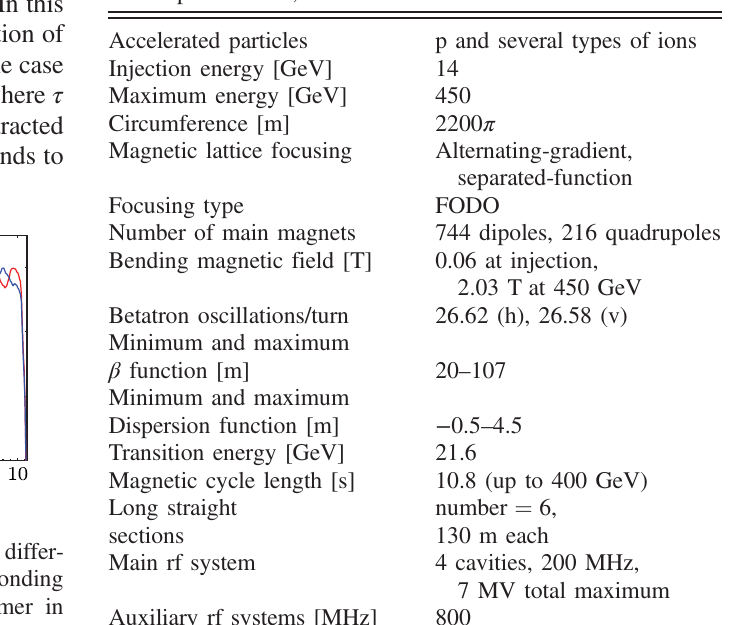
TABLE III. Basic parameters of the SPS ring. The cycle length refers to the time needed from injection up to extraction energy (including the time for single-, multi-turn, or slow beam extrac- tion) and back again to injection. Such a time is a multiple of the PSB repetition rate, which is 1.2